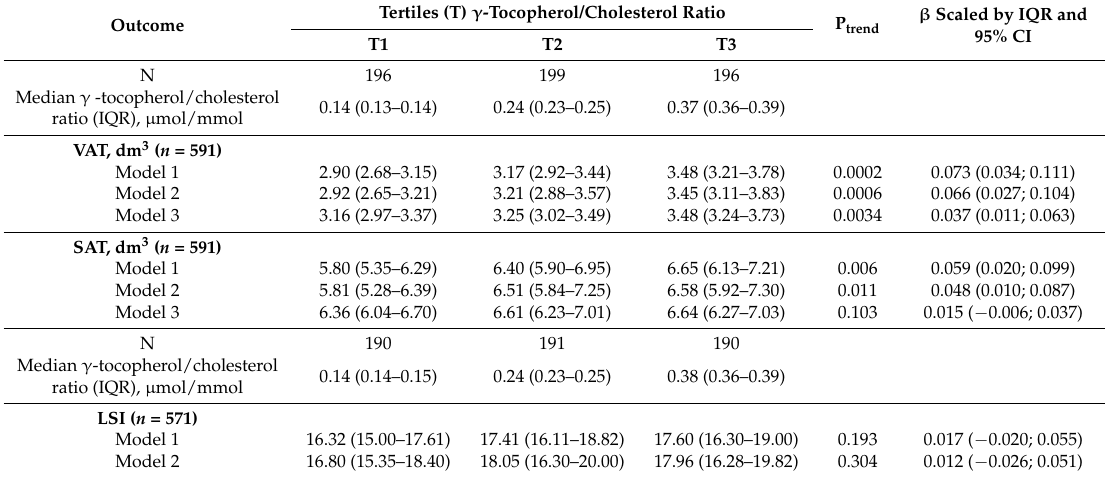
Table 4. Multivariable-adjusted means and 95% CI of VAT, SAT, and LSI according to tertiles of γ -tocopherol/cholesterol ratio, and scaled by IQR.